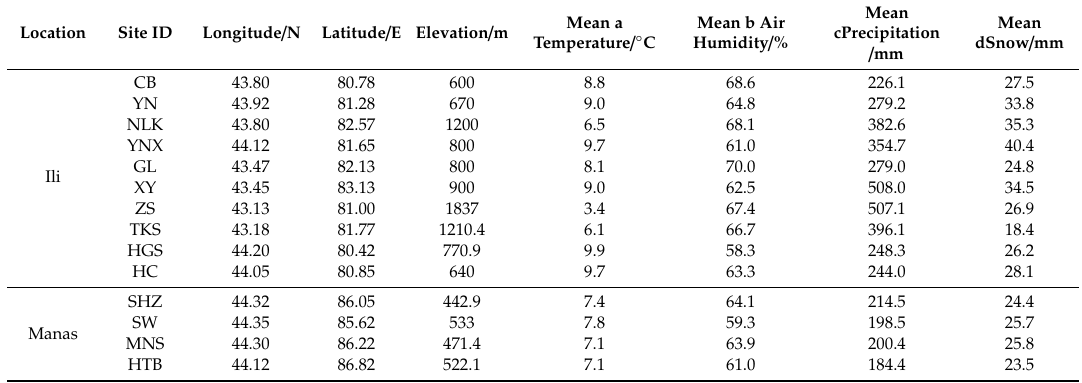
Table 2. Site information (site ID, longitude, latitude, and elevation) and average climate eigenvalue of the meteorological stations in the study area for the common period of 1950–2016. Long-term climatic data of each station contain mean temperature, mean air humidity, mean precipitation, and mean snow per